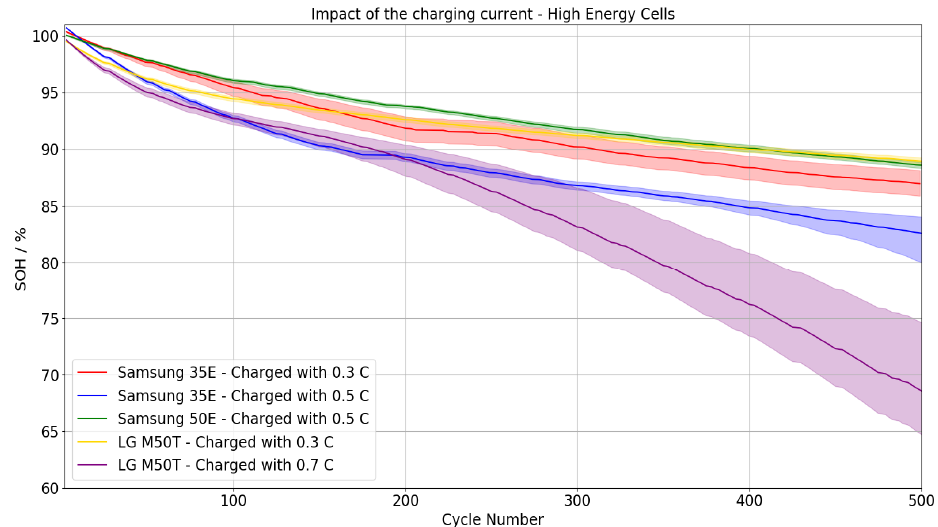
Figure 4. Development of the SOH during the cycle test of the high-energy cells. Solid lines represent the mean values, shaded areas represent the spread of the measured values.